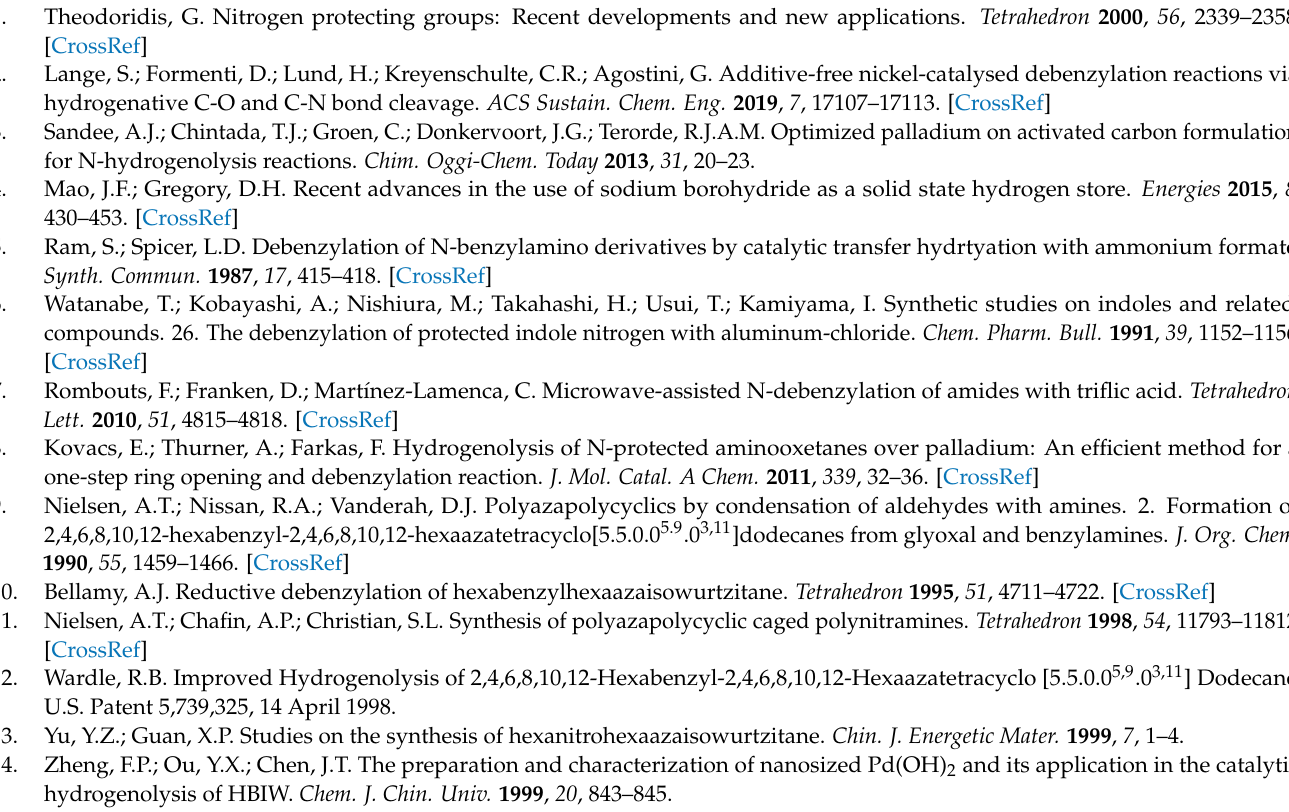
survey spectrum of various catalysts; Figure S8: High resolution of O 1s and C 1s XPS spectra of the catalysts; Figure S9: HPLC data of TADB crude product; Figure S10: 1 H-NMR figure of TADB in D 2 O; Figure S11: 1 H-NMR figure of TAIW in D 2 O; Table S1: Activities of Pd/HTC and Pd/HTC-N 1:1 in the three cycles of TADB debenzylation; Table S2: Surface atomic contents of different catalysts; Table S3: XPS binding energies of Pd species and the ratios in different catalysts; Table S4: XPS binding energies of N species and the ratios in different catalysts; Table S5: Calculated surface pyridinic N contents and surface pyridinic N/Pd molar ratios; Table S6: Surface atomic concentrations of the oxygen species of various catalysts; Table S7: Surface atomic concentrations of the carbon species of various